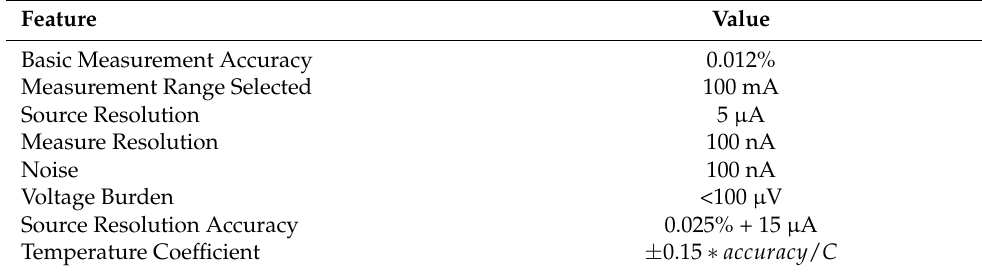
Table 4. Keithley 2450 SourceMeter Specifications